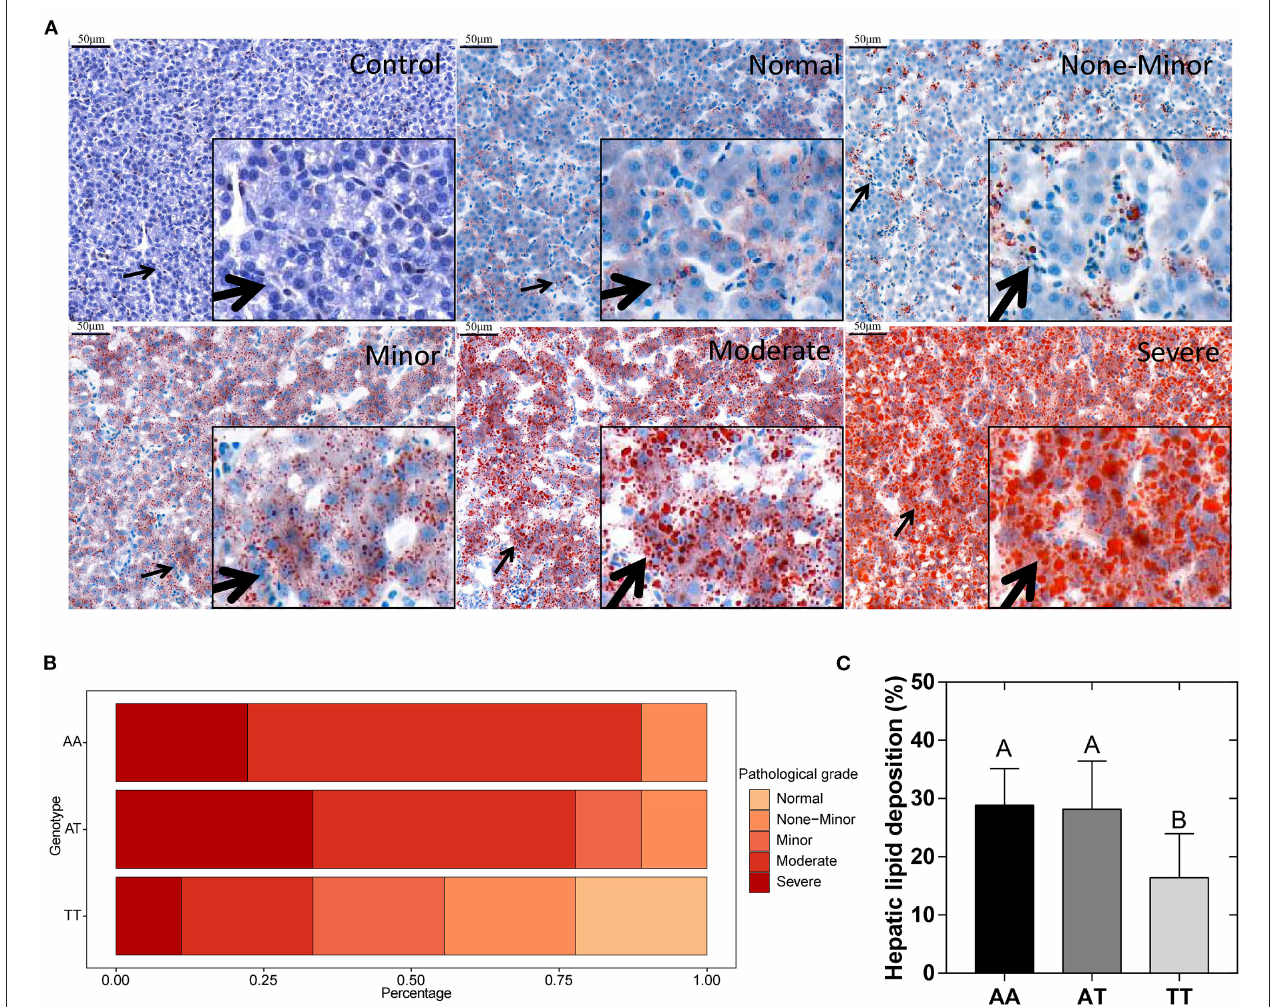
FIGURE 2 | (A) Histopathologic observations of chicken livers were divided into five grades representing the different degrees of fatty liver syndrome (arrows point to local tissue magnification). (B) Incidence rates of different grades of fatty liver syndrome in different genotyped layers. (C) Quantification of Oil red O staining results (% of the total area) of the liver. AA, AA genotype hens; AT, AT genotype hens; TT, TT genotype hens. Values are expressed as means ± standard deviation (SD); n = 9 hens with each genotype. A,B Means within a histogram with no common superscripts differ significantly ( P <